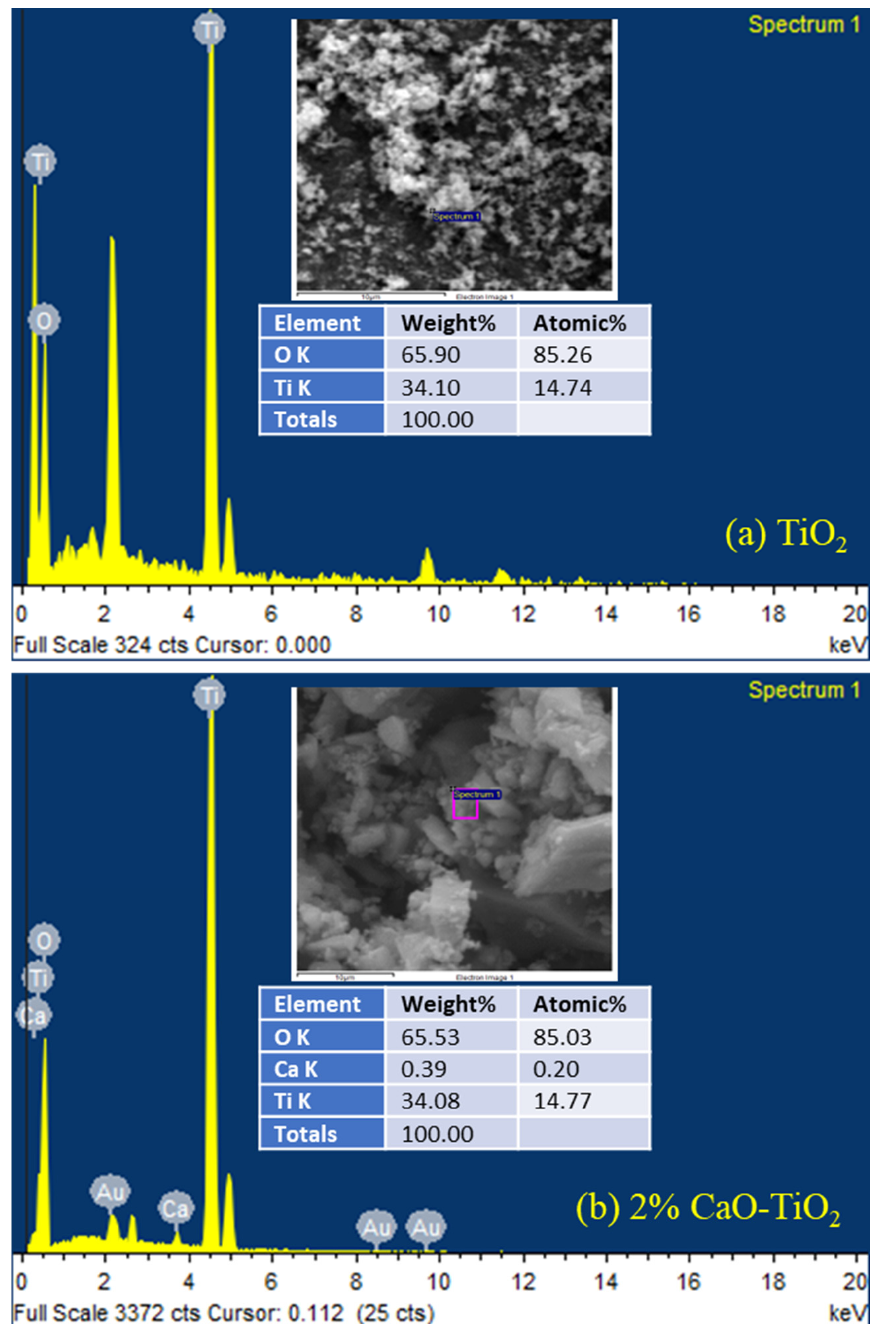
Figure 6. EDX analysis of ( a ) TiO 2 ( b ) 2% CaO-TiO 2 .